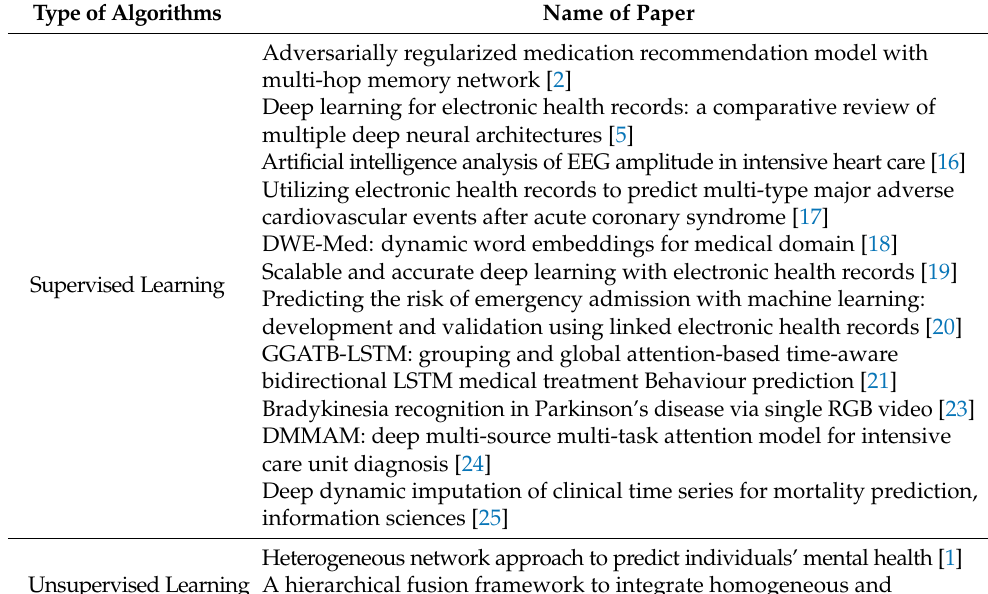
Table 1. Summary table. Type of